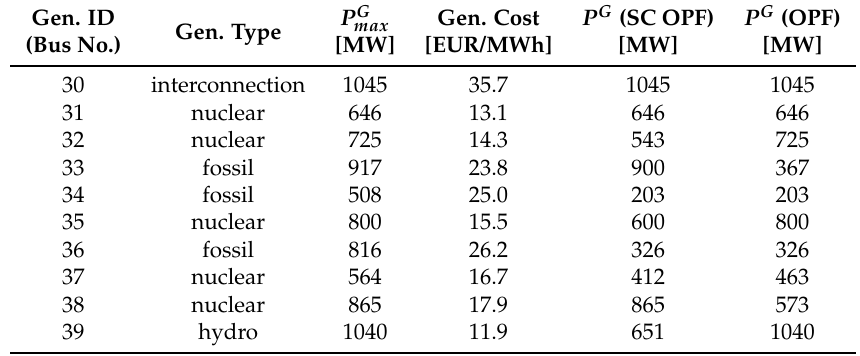
Table 1. The data sheet on generators in IEEE39 with the initial operating points for SC OPF and OPF